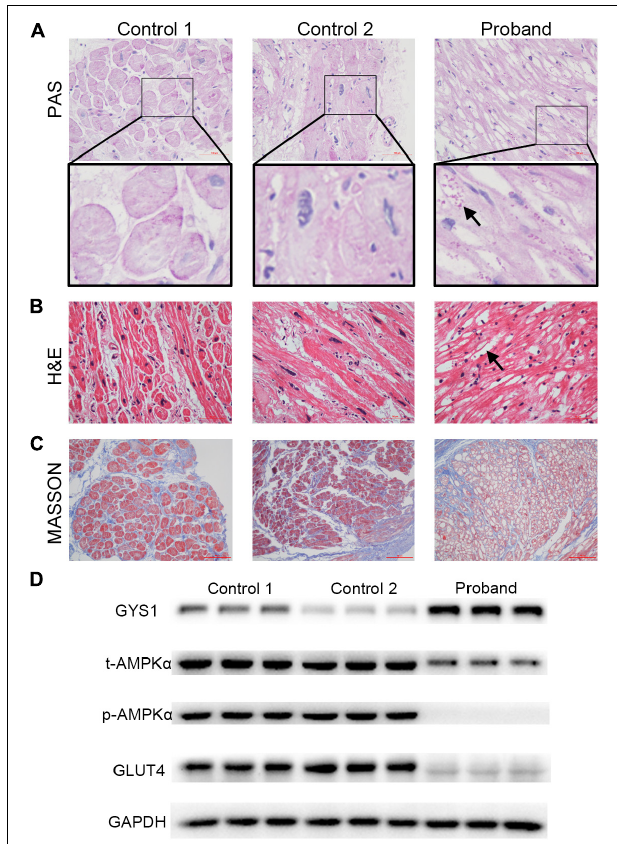
FIGURE 3 | Alterations in the pathology and protein expression of the left atrial appendage tissues of the proband. (A) Representative photograph of PAS staining results. Many glycogen granules were observed (indicated by the black arrow, scale bar = 100 µ m). (B) Representative images of H&E staining results. Distinct vacuolated myocytes (indicated by the black arrow) are visible (scale bar = 50 µ m). (C) Observation of severe fibrosis in cardiac tissues by Masson staining (scale bar = 50 µ m). (D) Western blotting of GYS1, t-AMPK α , p-AMPK α , GLUT4, and GAPDH. Abbreviations: GYS1, glycogen synthase 1; AMPK, 5 (cid:48) -AMP-activated protein kinase; GLUT4, glucose transporter 4.